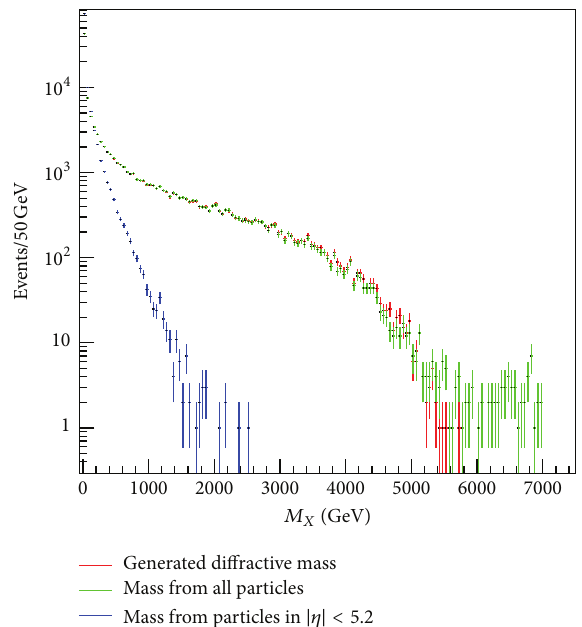
Figure 2: Distributionof thediffractive mass for SDD events simulated by PYTHIA8.142. Generated diffractive mass (redline) and calculated diffractive mass from all particles in the full 𝜂 coverage (green line) and in a limited 𝜂 coverage |𝜂| < 5.2 (blue